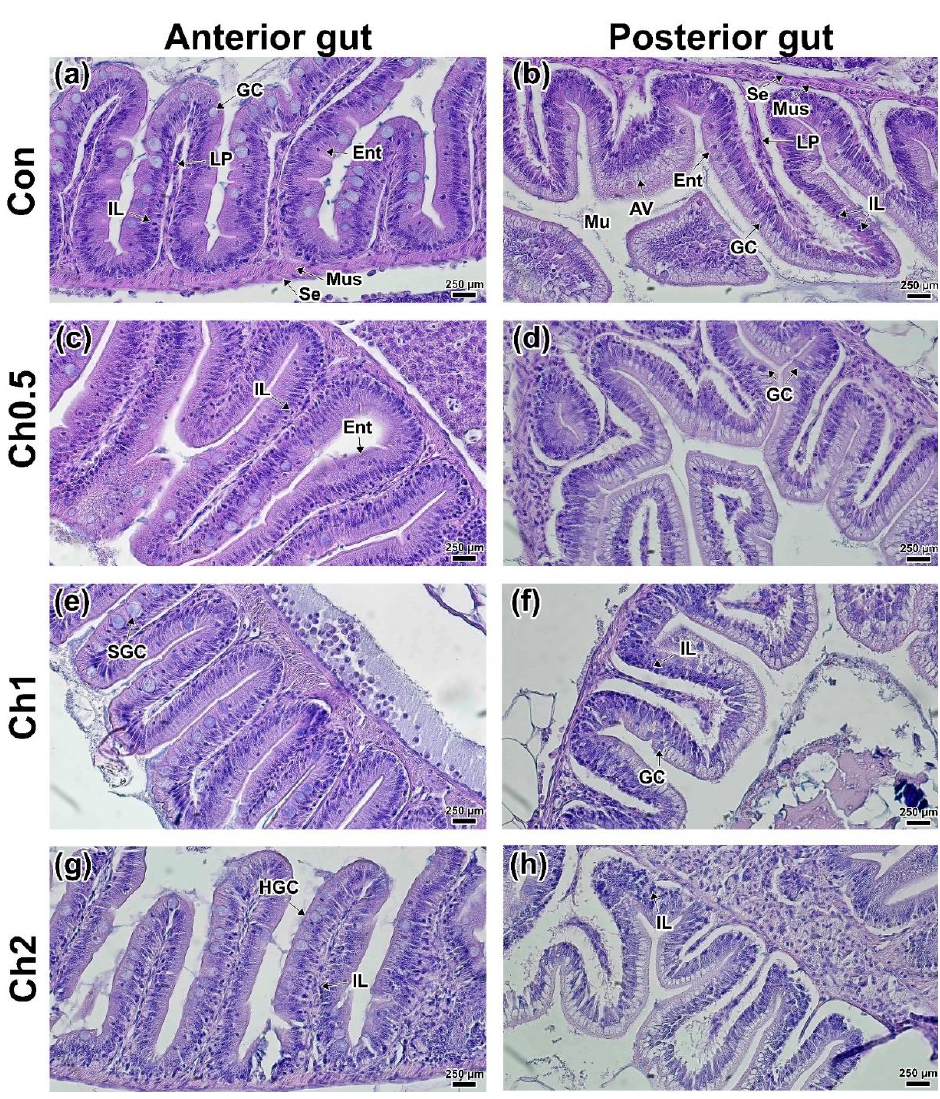
Figure 4. Histology of the anterior ( a , c , e , g ) and posterior ( b , d , f , h ) intestines of D. rerio of the experimental groups receiving chelated compounds of microelements and control: ( a , b ) control group; ( c , d )